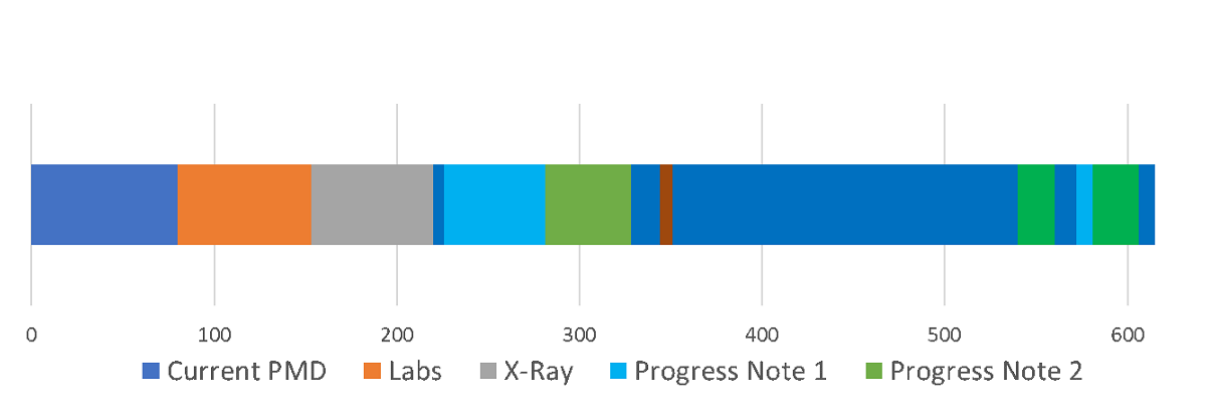
Figure 10. Time belt visualization of clinical tasks using experimental electronic health record (EHR)